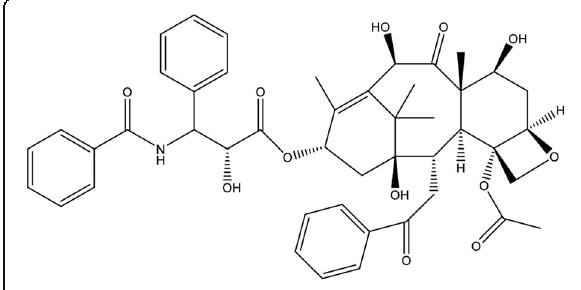
Fig. 5 Structure of fungal 7- epi -10-de-acetyl taxol (EDT)